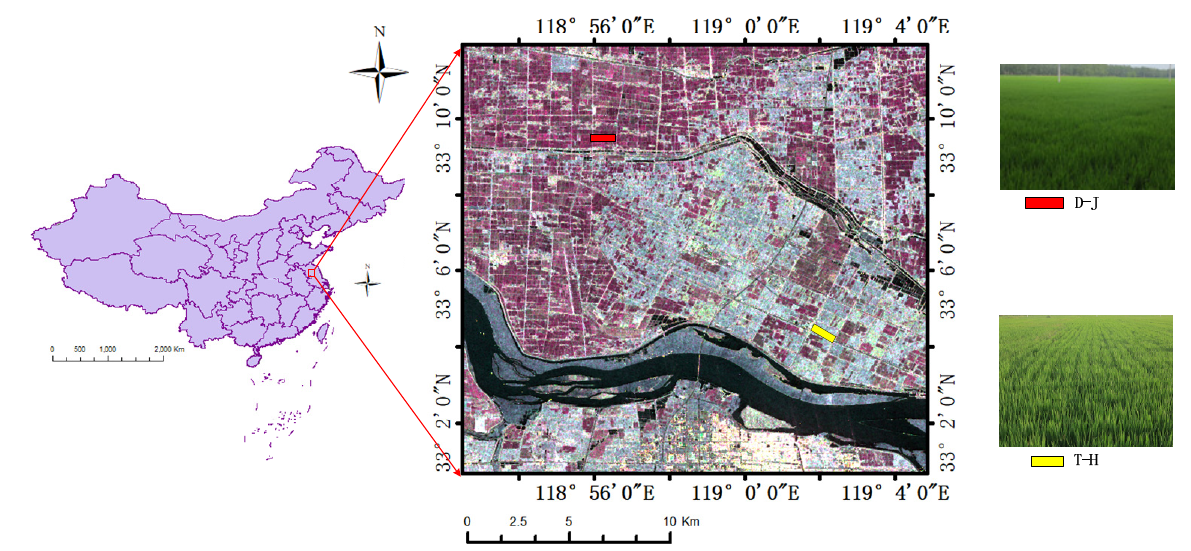
Figure 1. The color composite images (CP SAR RH (red), RV (green), and RR (blue)) of the backscattering coefficients of simulated CP SAR data on 3 November 2015; in the red box is our study area.